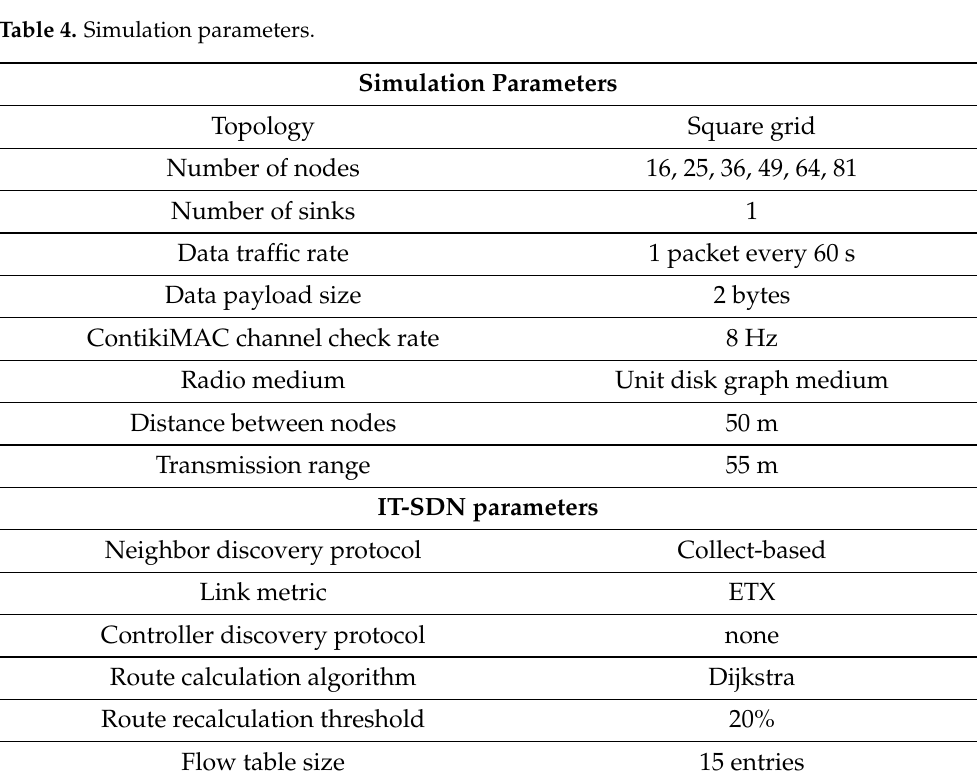
Table 4. Simulation parameters.